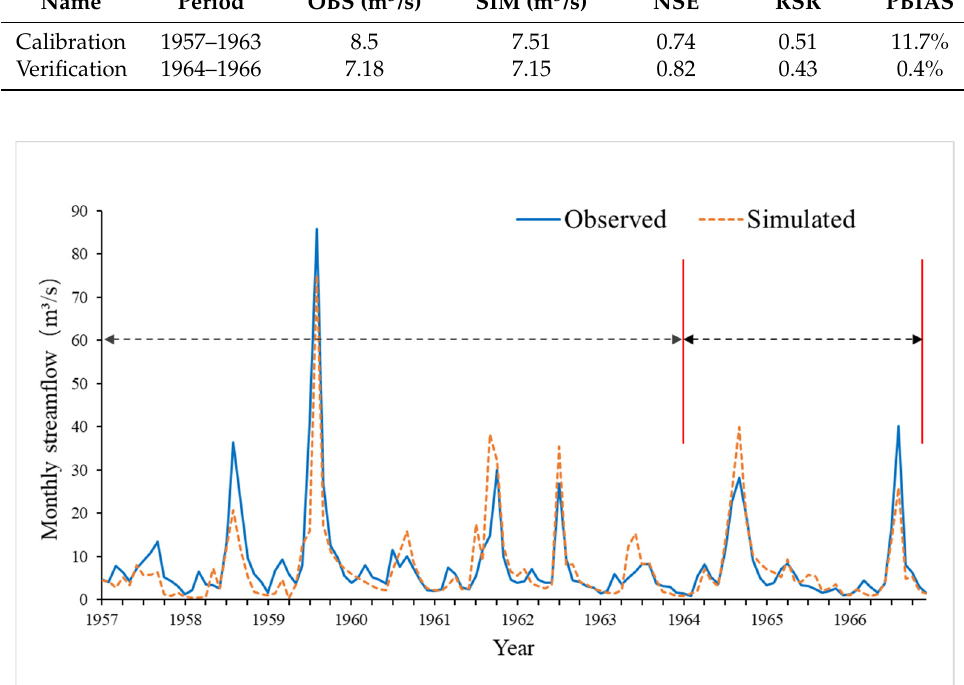
Figure 4. Hydrographs of the observed streamflow and the simulated streamflow from the SWAT modelling.